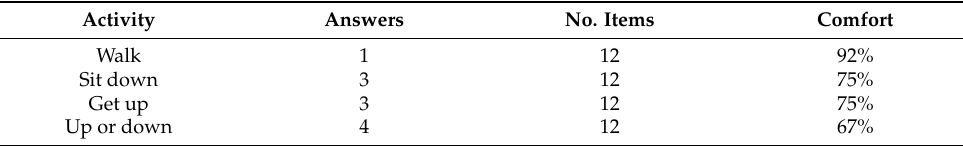
Table 5. Total user comfort for ergonomic socket.